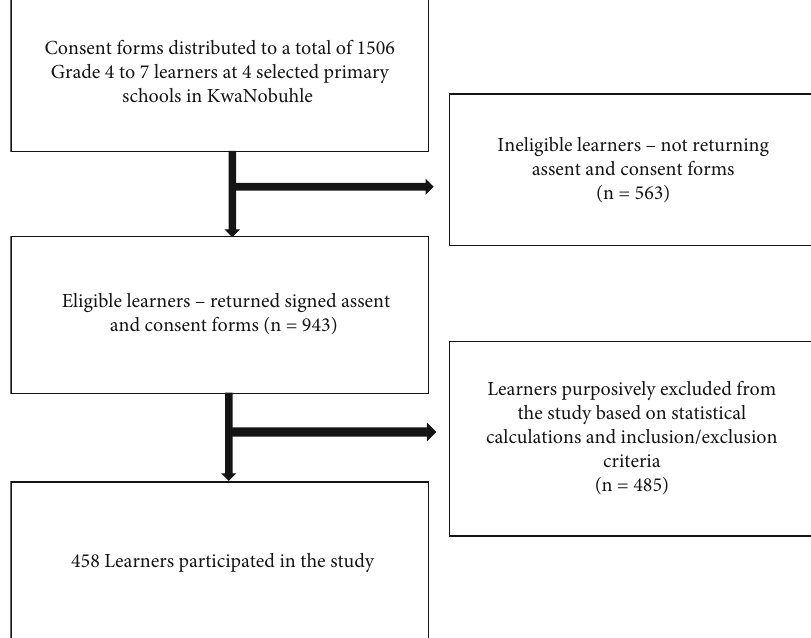
Figure 2: Flow chart of the participation and compliance in the present